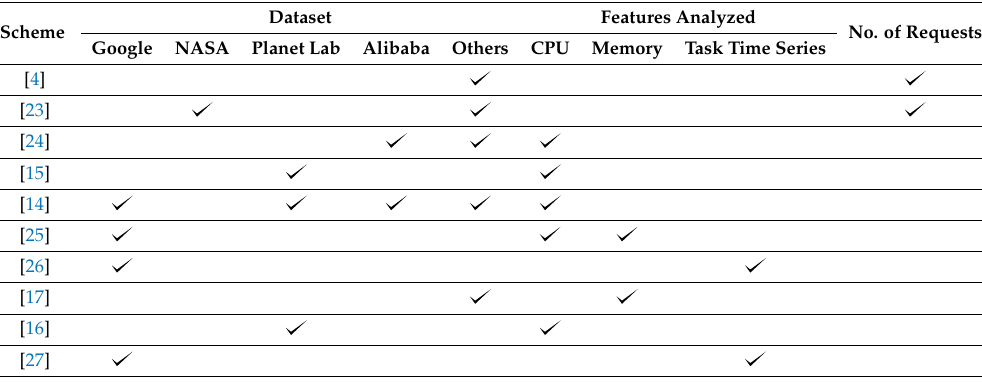
Table 3. Comparison of the dataset and analyzed features of the DL models.